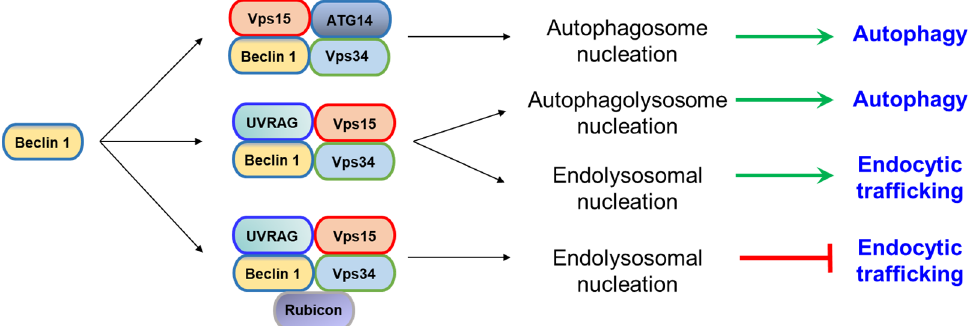
Figure 1. Beclin 1 forms several class III phosphatidylinositol 3-kinase (PI3KC3) complexes that regulate some steps of autophagy and endocytic trafficking.